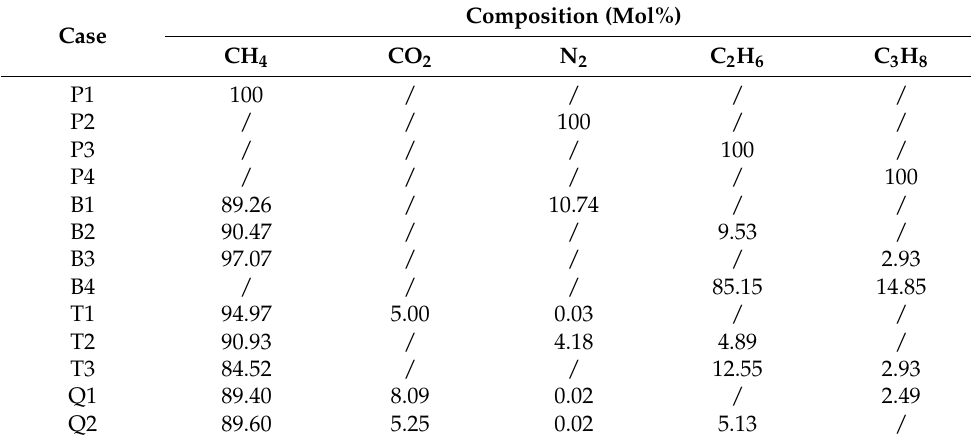
Table 4. Cases used in the verifications.